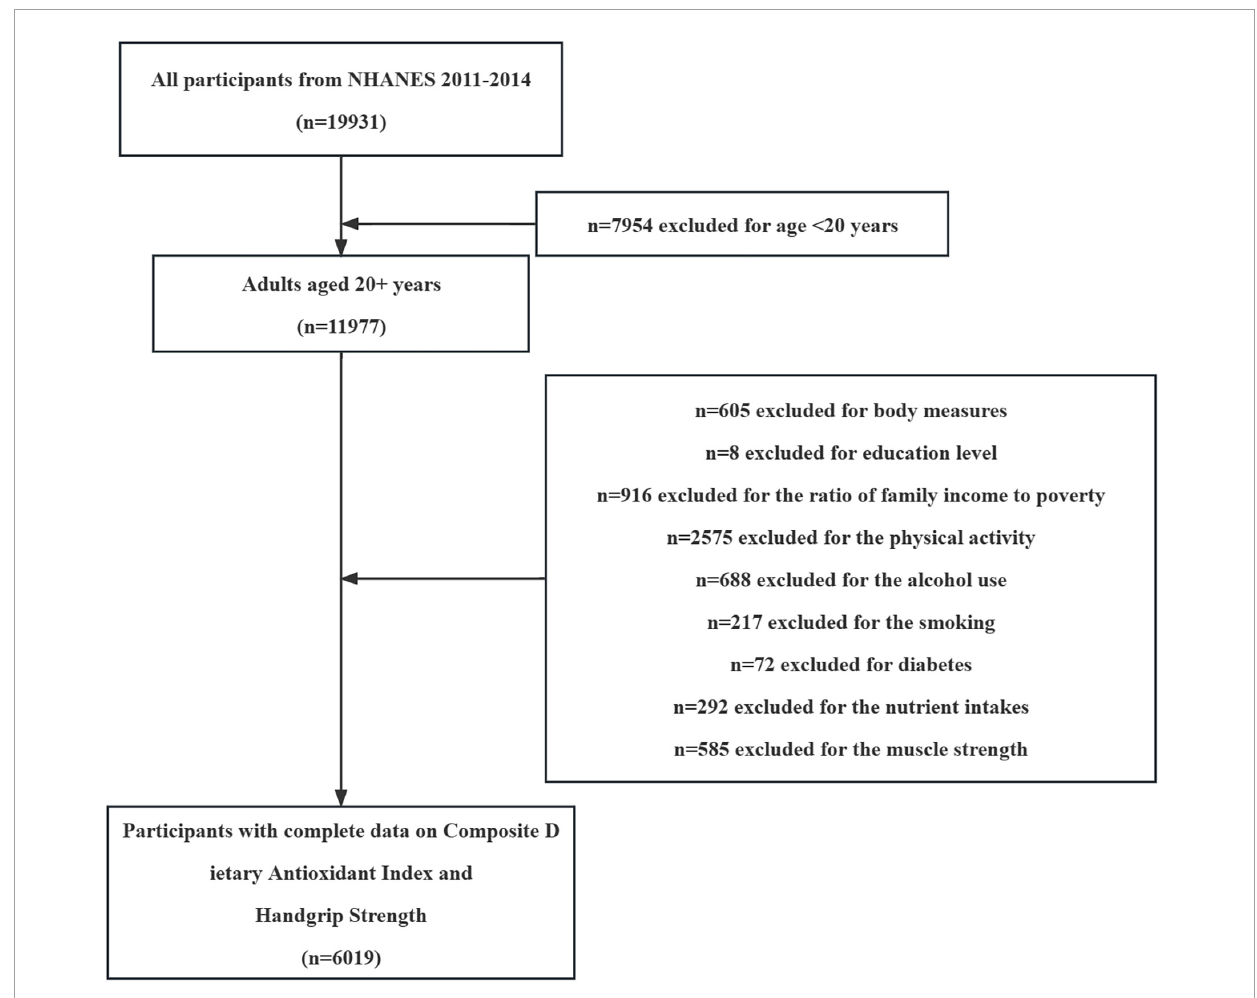
FIGURE1 Flowchart depicting participant selection in the study.